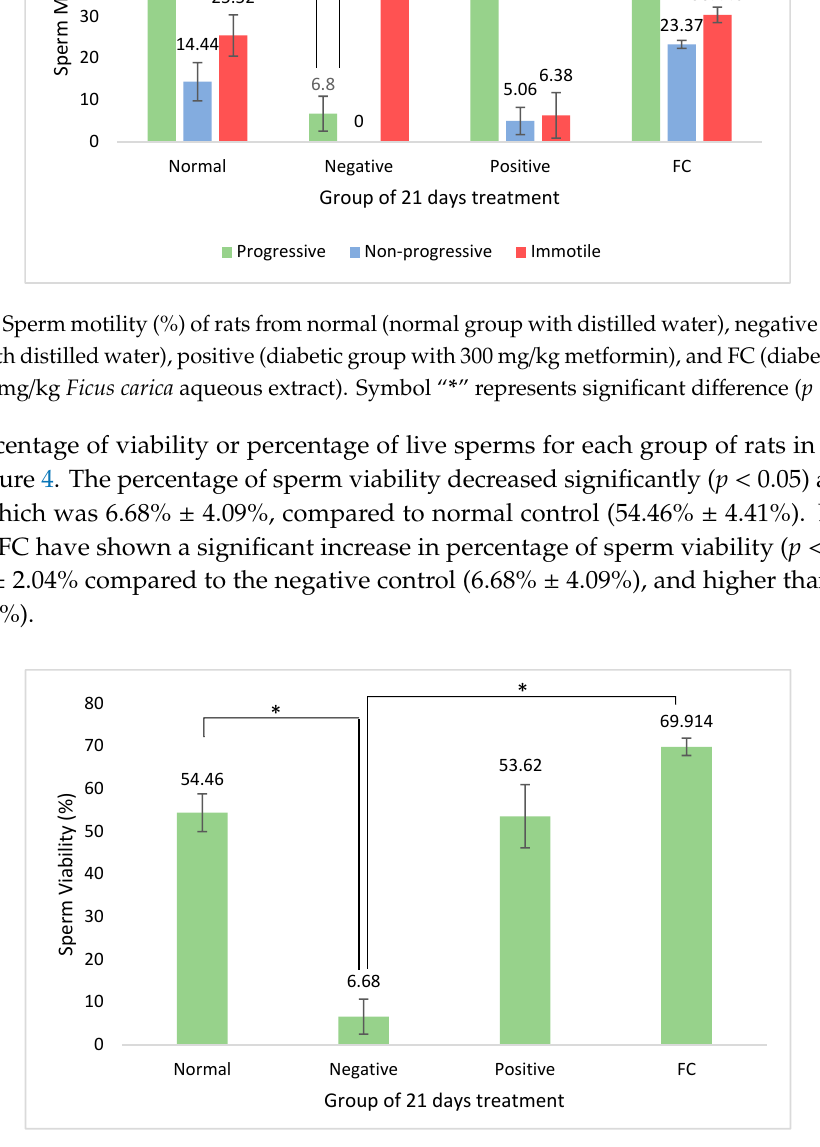
Figure 2. Sperm count (× 10 6 ) of rats from normal (normal group with distilled water), negative (diabetic group with distilled water), positive (diabetic group with 300 mg/kg metformin), and FC (diabetic group with 400 mg/kg Ficus carica aqueous extract). Symbol “ * ” represents significant difference ( p < 0.05).